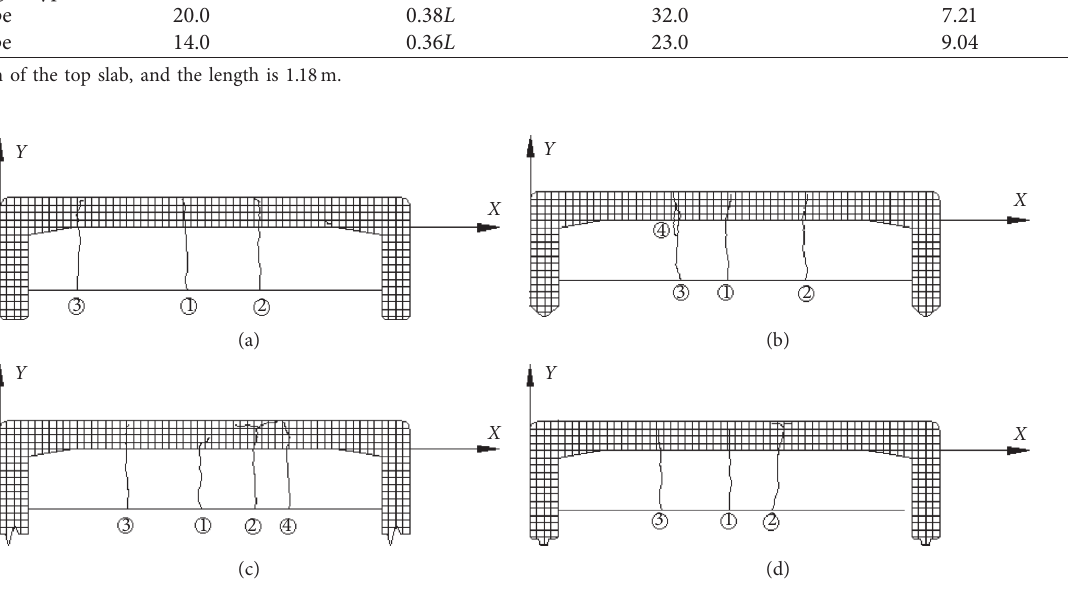
Figure 4: The crack distribution of prefabricated BC structure. (a) Flat seam type. (b) Round hinged type. (c) Integral type. (d) Mortise type. ① , ② , ③ , and ④ are the order of crack